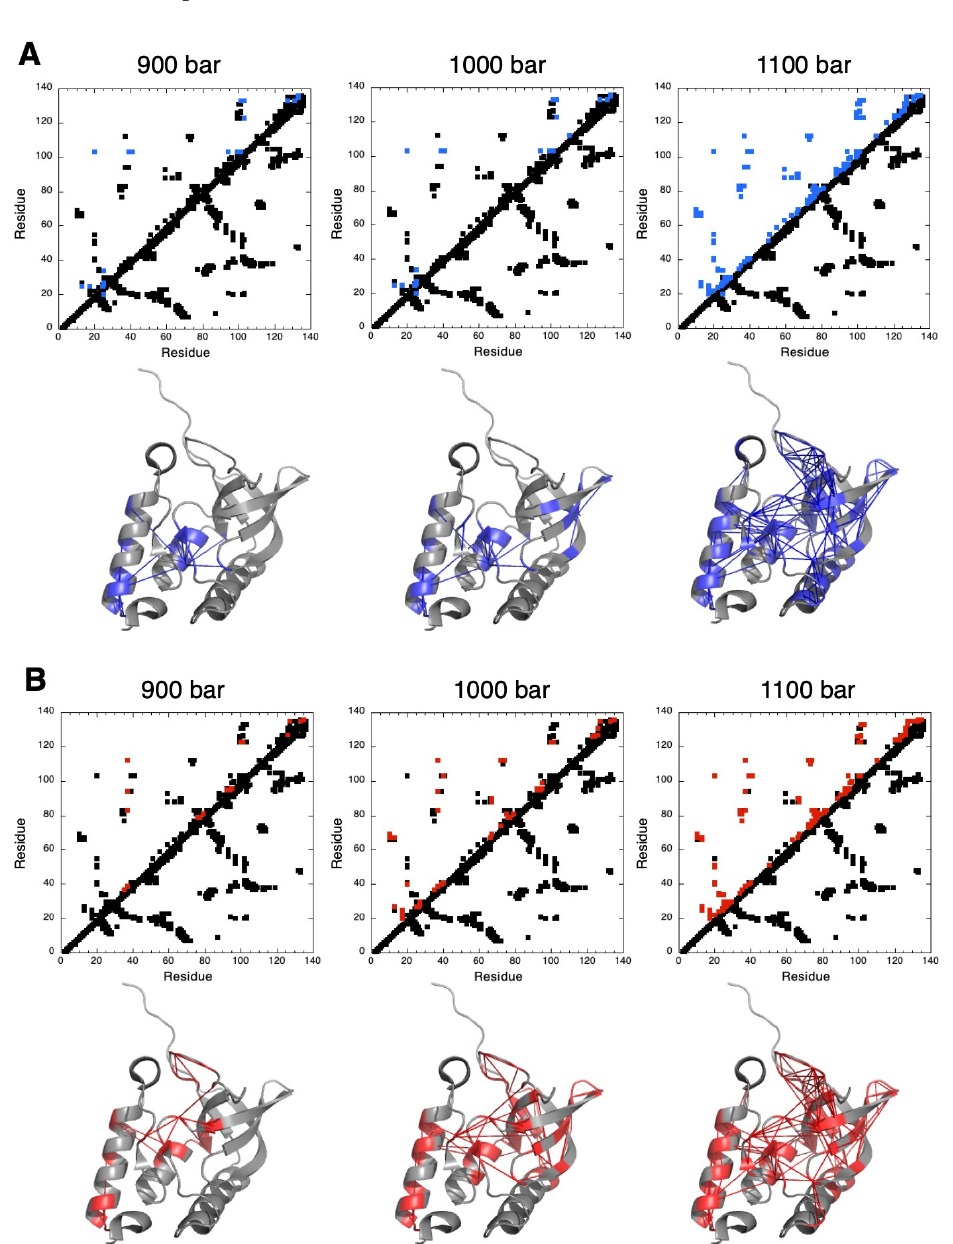
Figure 5. Pressure denaturation of ∆ +PHS SNase probed by NH and C α H α backbone atoms. ( A ) Upper panels: contact maps built from the crystal structure of ∆ +PHS SNase (PDB ID: 3LX0) at 900, 1000, and 1100 bar, as indicated. Contacts below the diagonal have been calculated with CMview: they correspond to residues where the distance to the corresponding C α is lower than 8.5 Å. Above the diagonal, the contacts displayed correspond to residues for which fractional probability can be measured from normalized residue-specific denaturation curves obtained from NH cross peaks. In addition, contacts have been colored in blue when contact probabilities P ij lower than 0.5 are observed. Lower panels: visualization of the probabilities of contact on ribbon representations of ∆ +PHS SNase at 900, 1000, and 1100 bar, as indicated. The blue lines represent contacts that are significantly weakened ( P ij ≤ 0.5) at the indicated pressure. Residues involved in these contacts are also colored in blue. ( B ) Similar as in ( A ), but the fractional probabilities have been calculated from normalized residue-specific denaturation curves obtained from C α H α cross peaks. In the contact maps, contacts have been colored in red when contact probabilities P ij are lower than 0.5. These weakened contacts are visualized on the 3D structure of ∆ +PHS SNase by red lines, and the residues involved in these contacts are also colored in